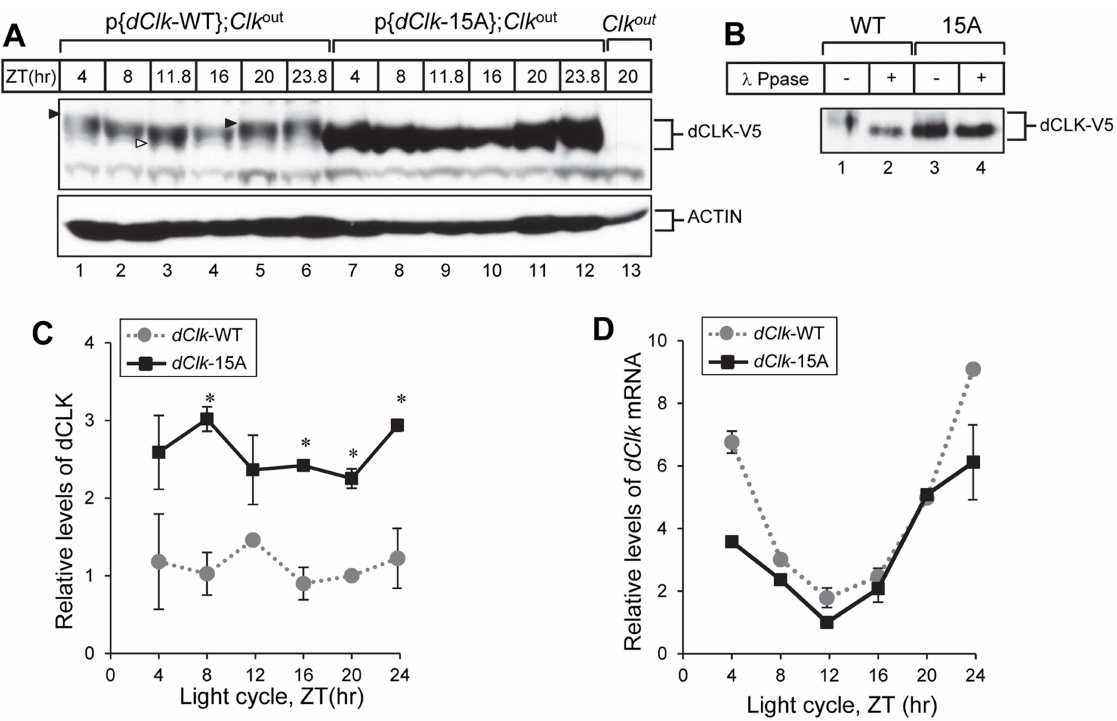
Figure 3. The levels of dCLK are substantially higher and hypo-phosphorylated at all times of the day in p{ dClk -15A}; Clk out flies. (A– C) Adult flies of the indicated genotype were collected at different times of day (ZT), head extracts prepared and directly analyzed for immunoblotting (A) or processed for immunoprecipitation with anti-V5 Ab (B). b -Actin (ACTIN) served as a loading control. Immune complexes were further incubated in the absence ( 2 ) or presence ( + ) of l phosphatase and immunoblotted with anti-V5 antibody, as indicated (B). Filled arrowheads denote hyper-phosphorylated isoforms of dCLK and open arrowhead denotes hypo-phosphorylated isoforms of dCLK (A). (C) Relative levels of dCLK were determined by measuring staining intensities using image J software. Shown are the average values from three independent experiments. (D) Total RNA was extracted from fly heads, and quantitative real-time RT-PCR was performed to measure the relative levels of dClk transcripts. Shown are the average values from three independent experiments using p{ dClk -15A}, 6M; Clk out flies. Error bars denote SEM.